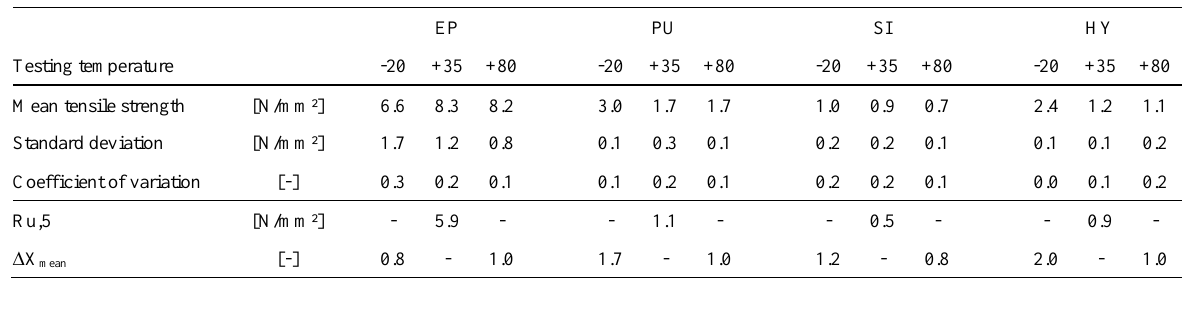
Table 1: Tensile strength during different test temperature.